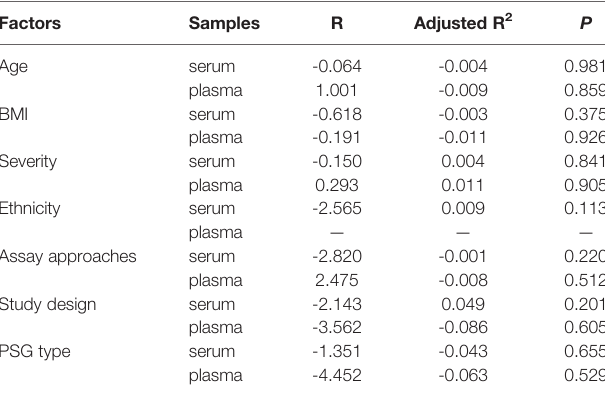
TABLE 4 | Meta-regression analysis of variables predicting serum and plasma levels of leptin.